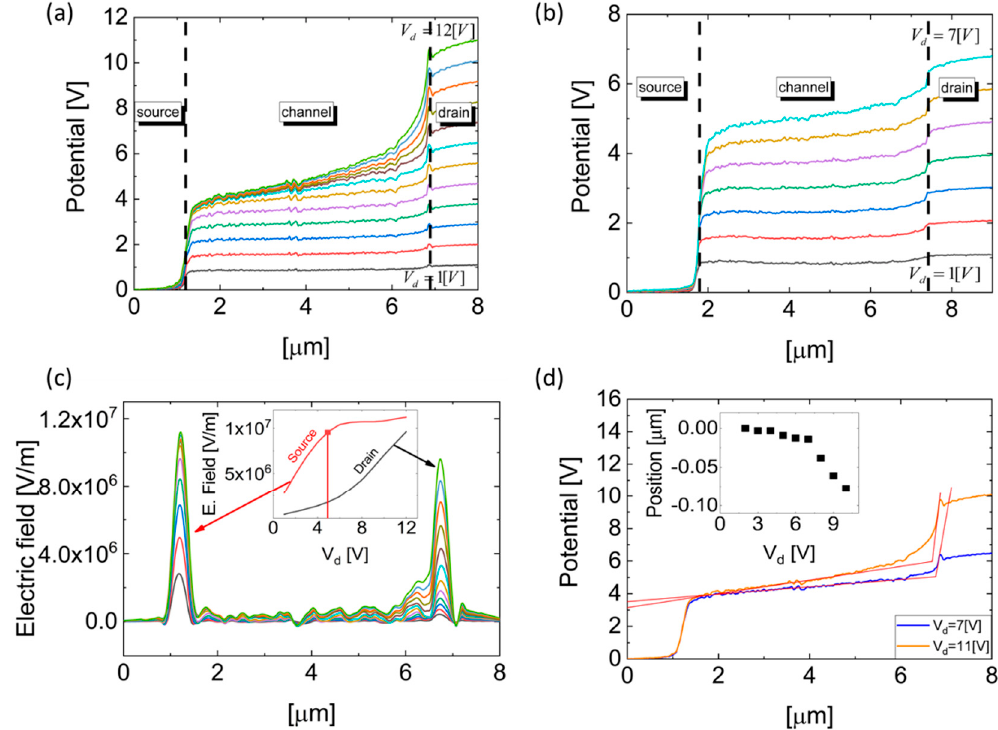
Figure 2. ( a ) Electrostatic potential measurements at varying drain voltages ( V d = 1 V to V d = 12 V with 1 V steps), while gate and source electrodes are grounded. ( b ) Electrostatic potential measurements at varying drain voltages ( V d = 1 V to V d = 7 V with 1 V steps), while V g = 5 V and the